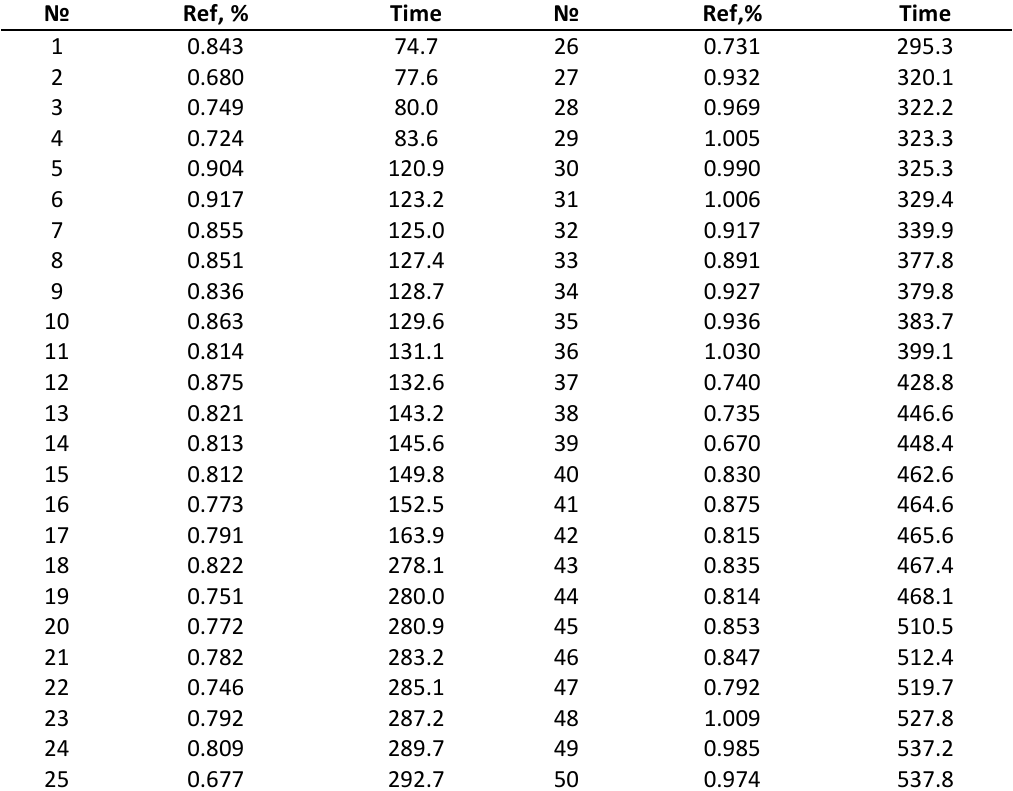
from the petrographic patterns of borehole VIII coal samples. Vt